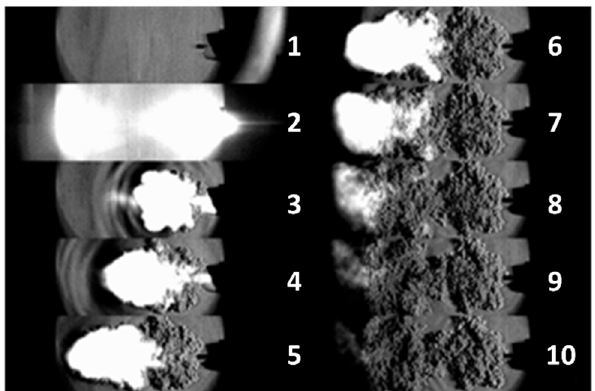
Figure 1. Images of the stimuli emanating from the transmission fuse following initiation recorded with Schlieren optics at a time resolution of 1 µs between images. 1. Tube image prior to initiation. 2. Initial light emission preceding shock front. 3, 4. Pressure wave ripples together with white hot gas emission. 5–10. Gas emission followed by other combustion products.